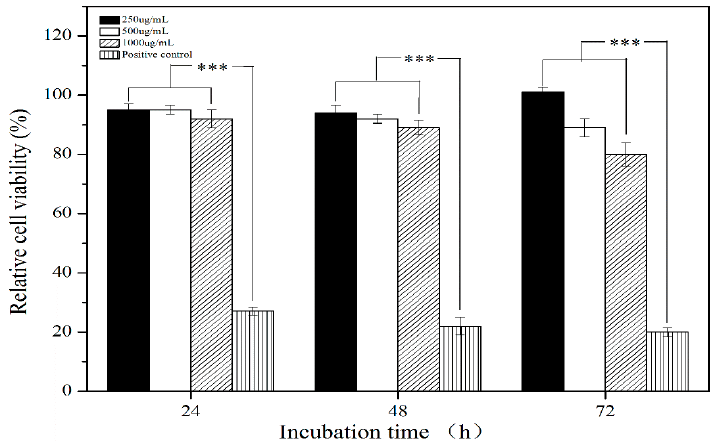
Figure 7. Relative cell viabilities of A549 cells cultured under different conditions. *** P < 0.01.